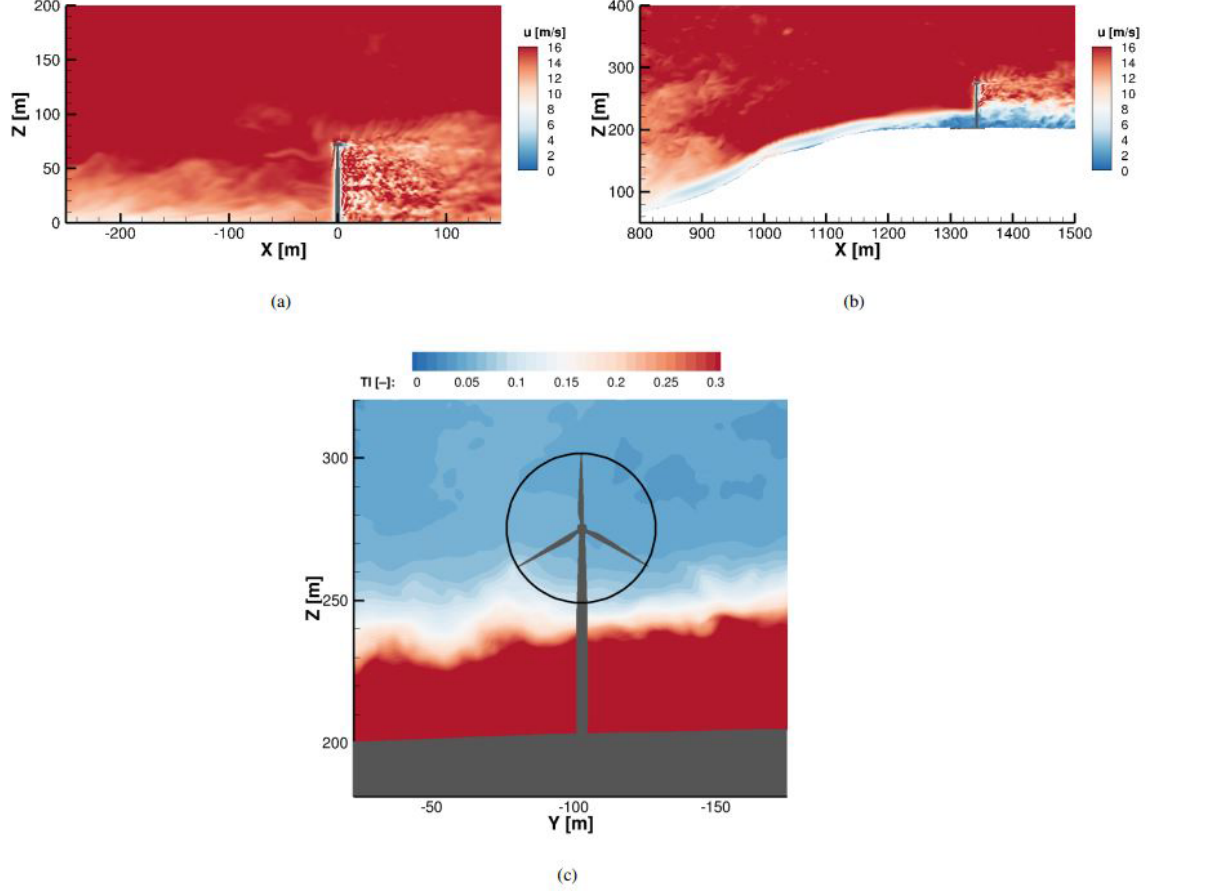
Figure 11. Vertical plane with interaction of the turbulent inflow in flat terrain (a) and complex terrain with forest (b) . Average TI over 1min in a plane 1R upstream rotor position (c)